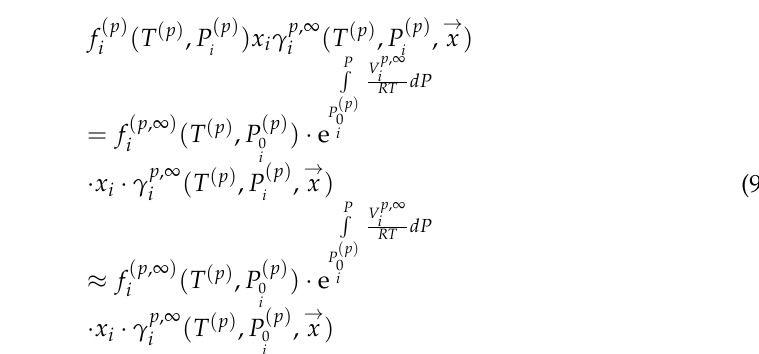
Ideal Liquid Mix → x T, P,